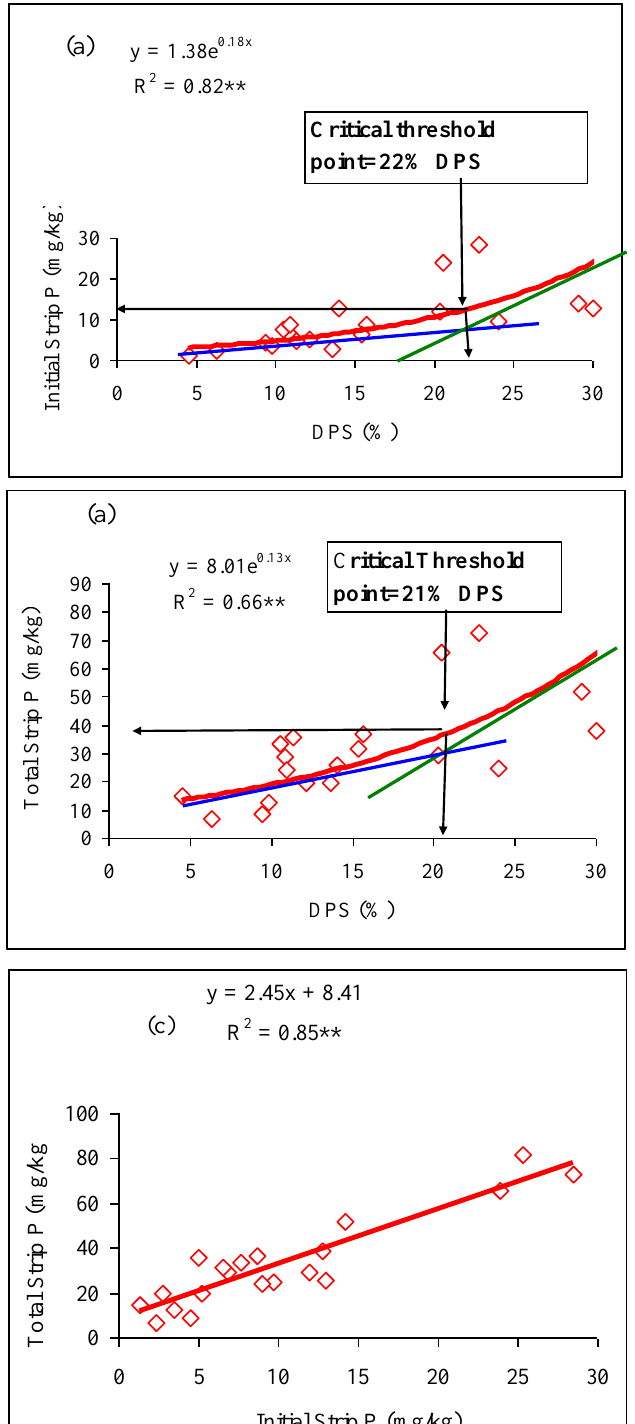
FIGURE 3. Relationship between (a) initial strip P vs. DPS, (b) total strip P (nine strips) vs. DPS, (c) total strip P vs. initial strip P. Note: different scales for a, b, and c to enable easy plotting of the threshold points. The blue and green lines in a and b are the tangents for the lower and upper slopes, respectively. The point where the two intersect is considered the change point of the slope and the corresponding strip P is the critical P